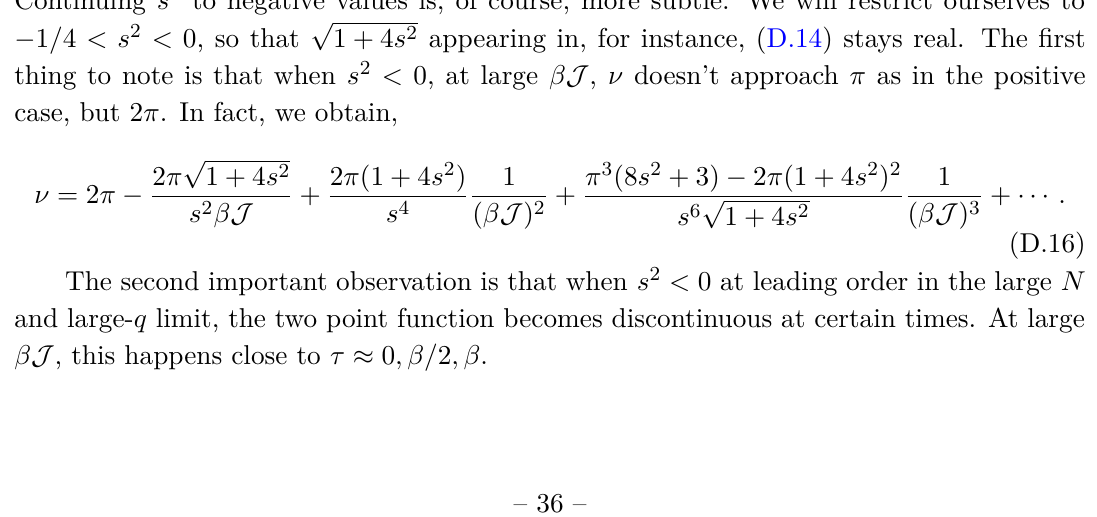
as a function 2 = 2